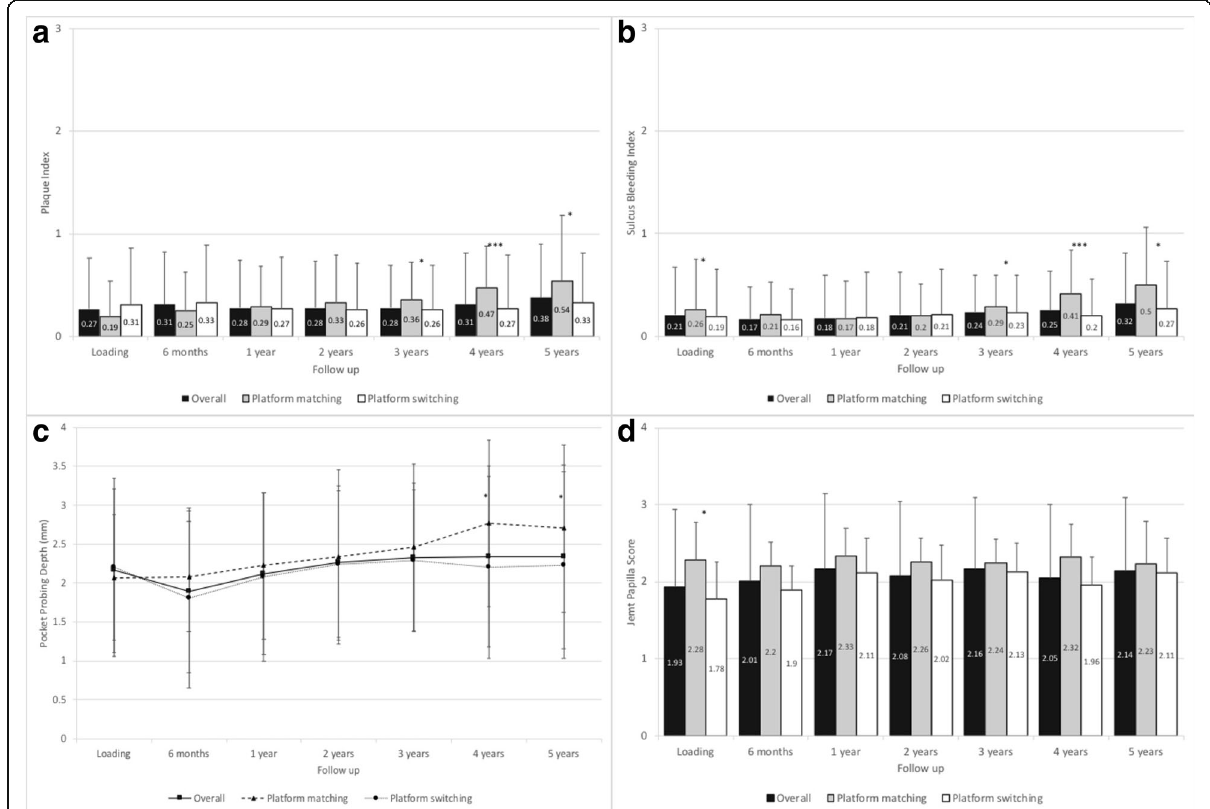
Fig. 2 Clinical parameters and soft tissue parameters. a Modified plaque index. Error bars indicate standard deviation. * = p ≤ 0.05, *** = p ≤ 0.001. b Sulcus bleeding index. Error bars indicate standard deviation. * = p ≤ 0.05, *** = p ≤ 0.001. c Pocket probing depth. The asterisk represents statistically significant differences (* = p ≤ 0.05) observed between subgroups. d Jemt papilla score. The asterisk represents statistically significant differences (* = p ≤ 0.05) observed between